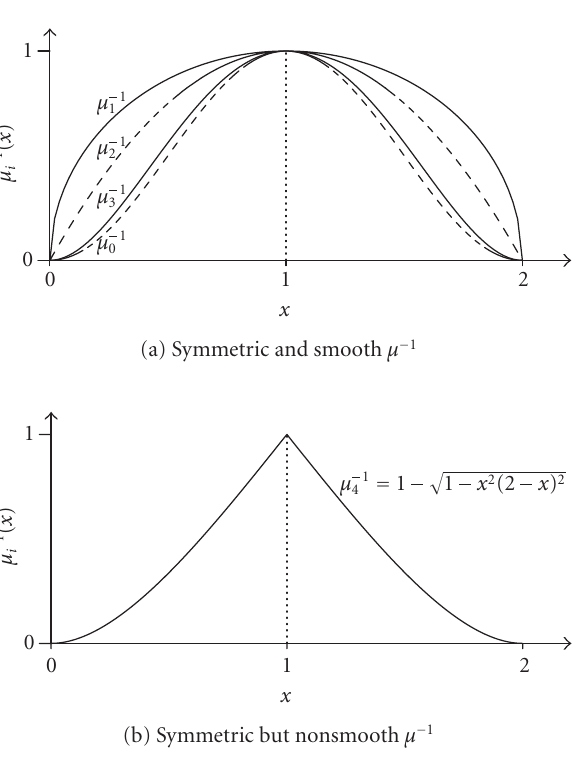
Figure 3.1. Odd-symmetricity of μ − 1 in